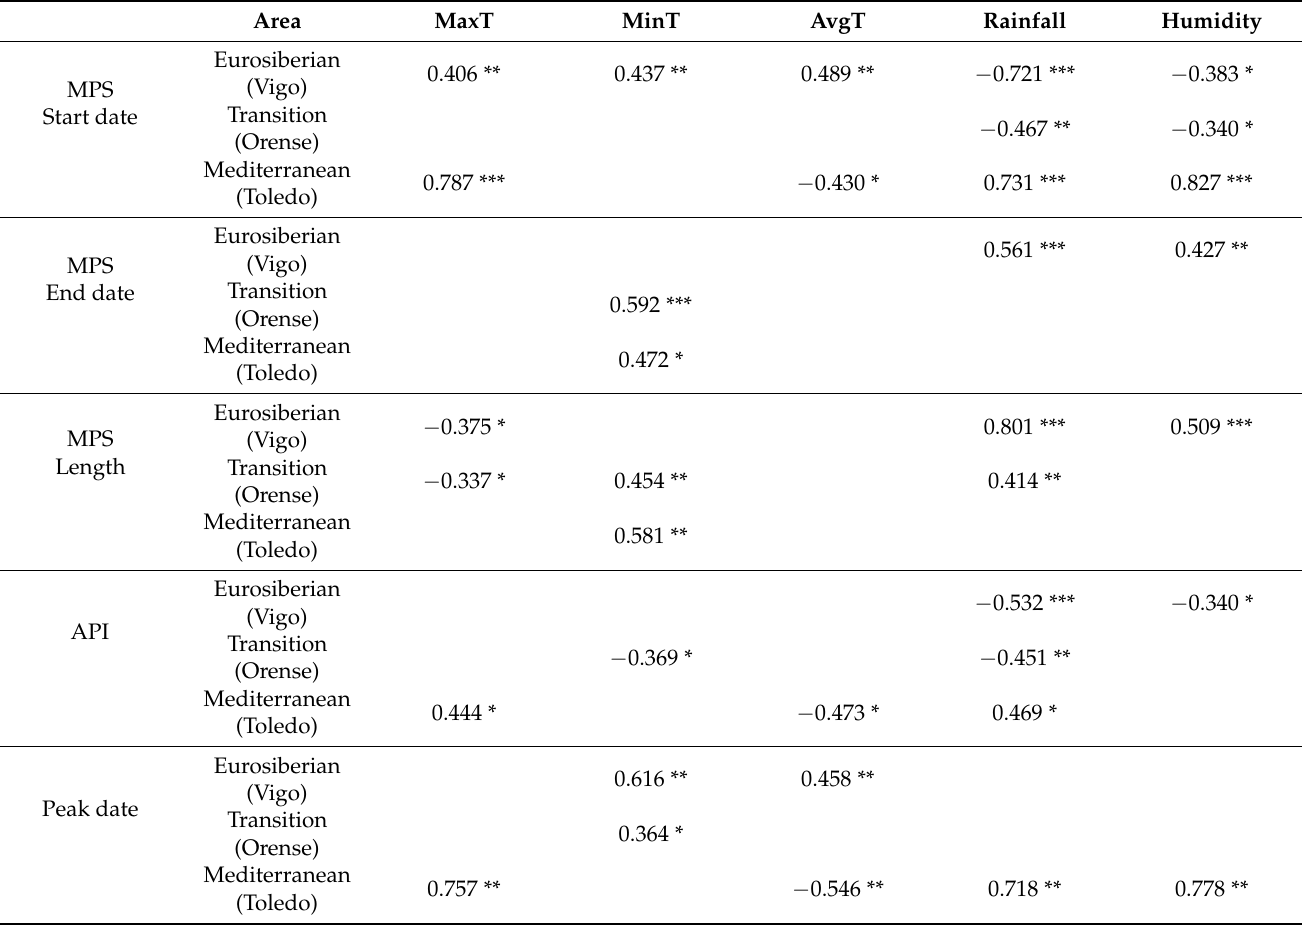
Table 4. Spearman correlations between the MPS characteristics (start, end and length dates of the MPS, API and pollen peak day) and the meteorological variables (maximum, minimum and average temperatures, total rainfall and relative humidity). Significance level was represented as * p < 0.05, ** p < 0.01, *** p < 0.01.